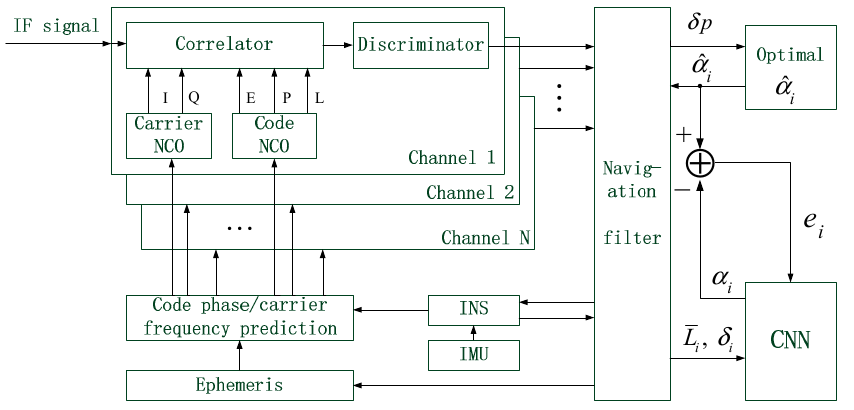
Figure 3. The system structure during the training stage of CNN.